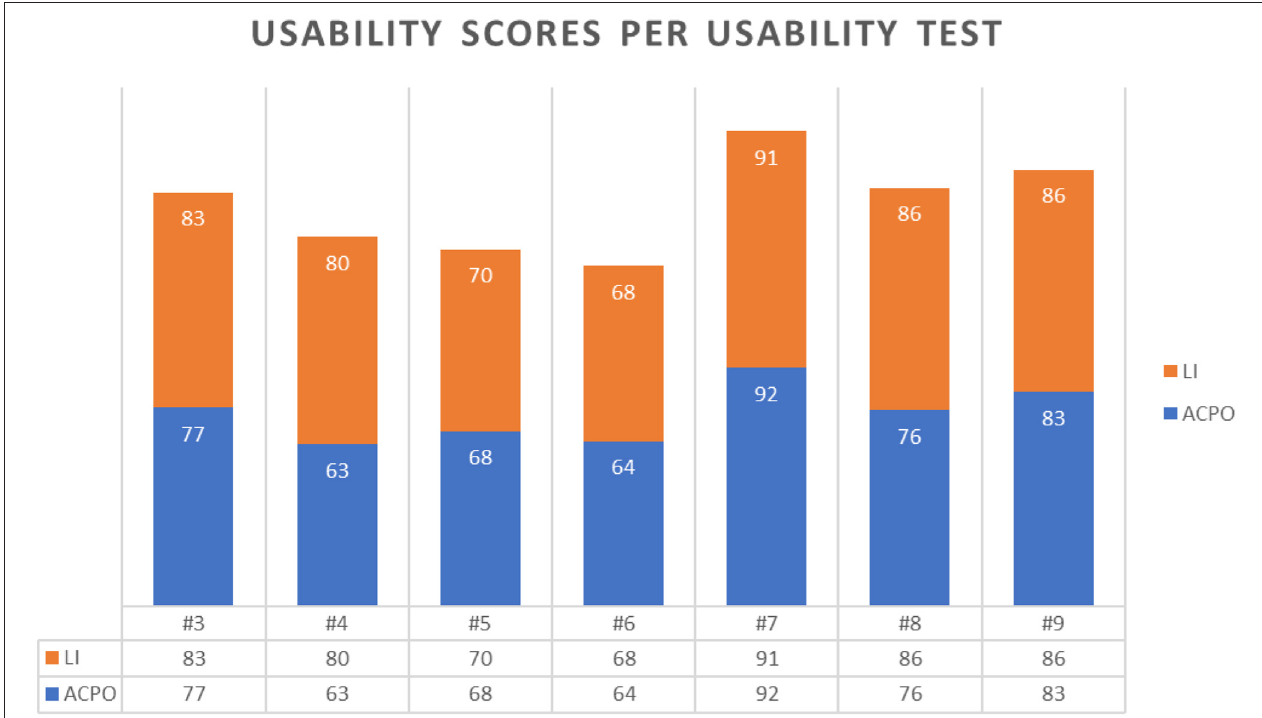
FIGURE 10 | Usability scores per usability test.